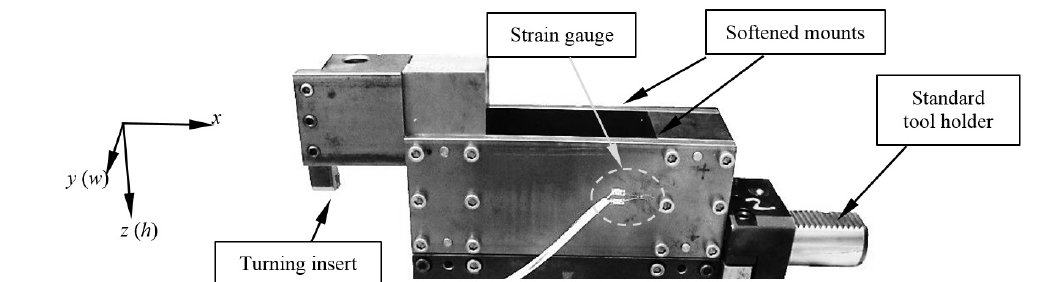
Figure 4. The softened tool mount and the fabricated strain gauges.